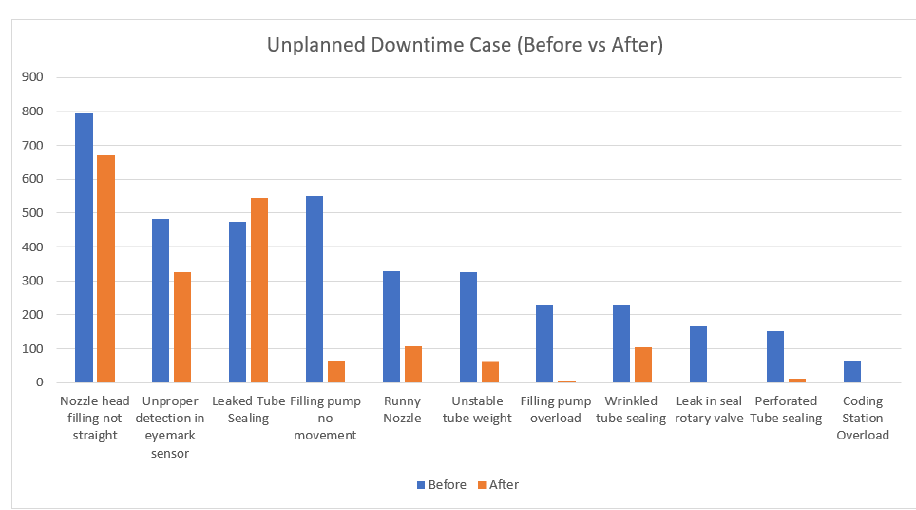
Figure 13. Update case reduction before vs. after system implementation.